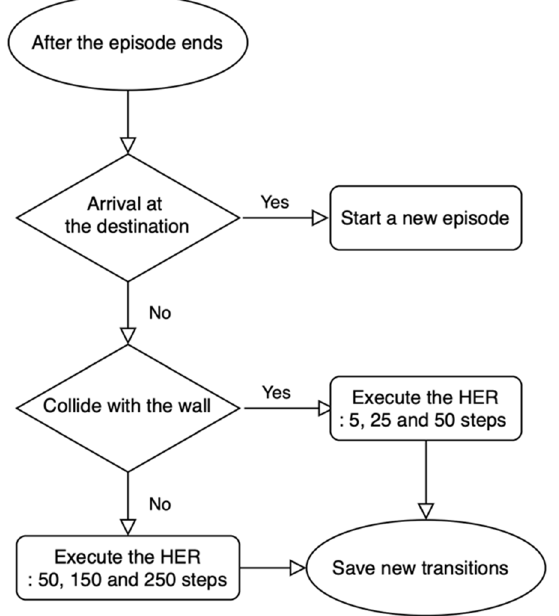
Figure 5. Flowchart for generating new data transitions using the hindsight experience replay (HER) technique.